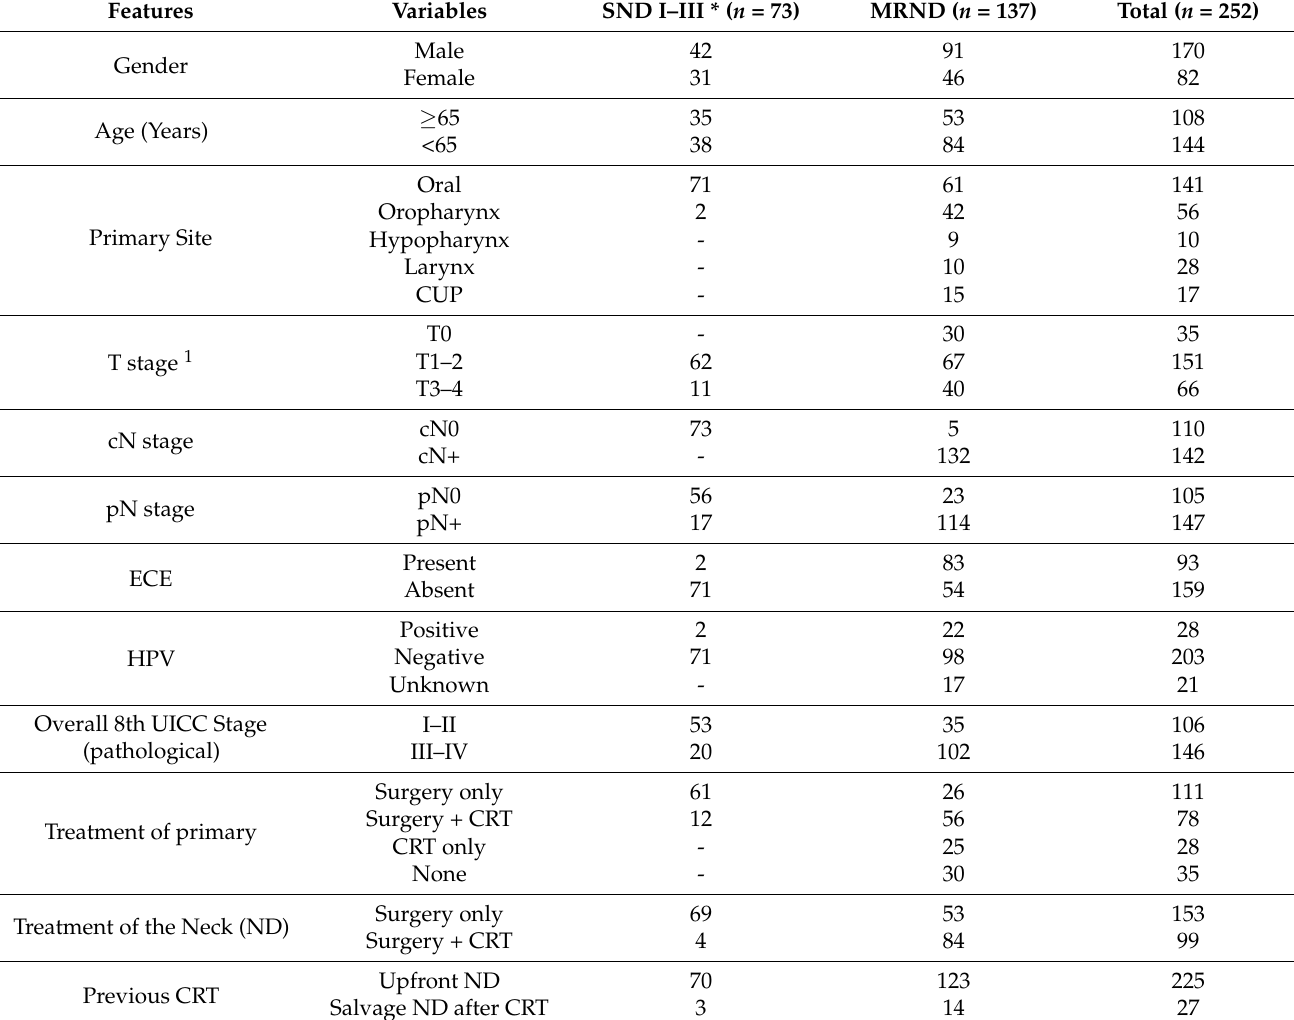
Table 1. Clinical and pathological features. n =